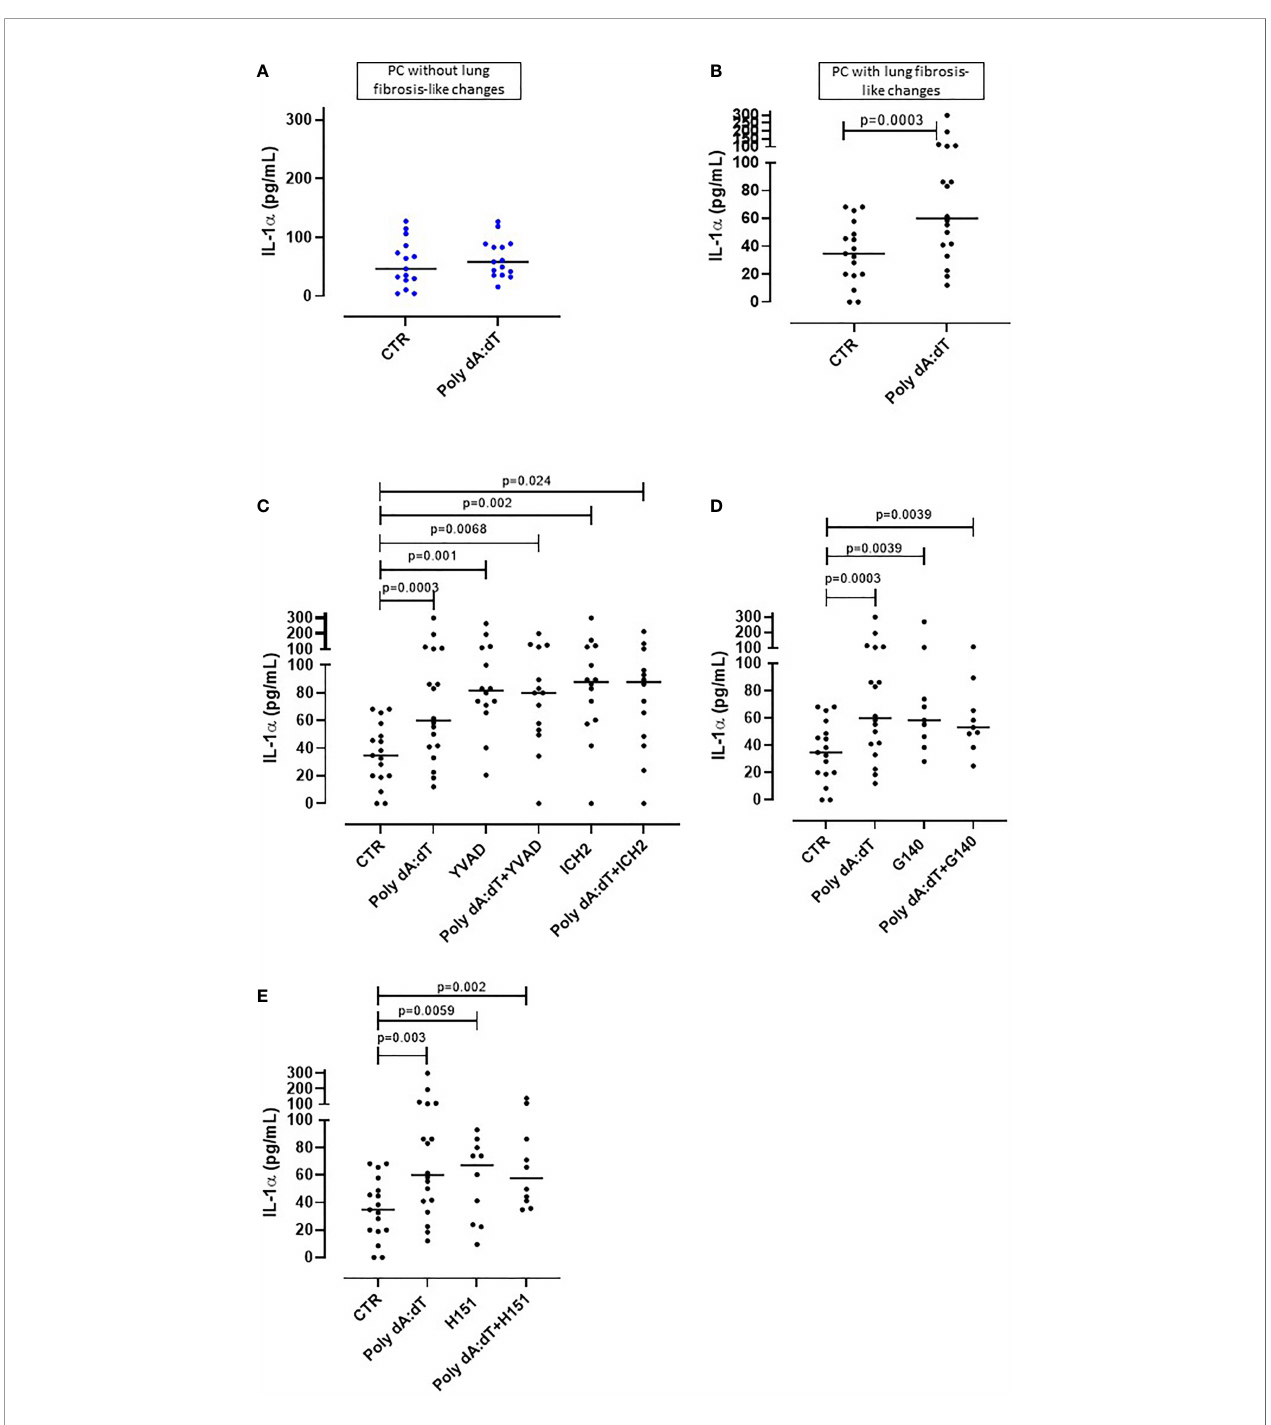
FIGURE 1 | AIM2 receptor activation induced IL-1 a release from PBMCs from Post-COVID-19 patients with fi brosis. PBMCs were stimulated with Poly dA:dT (1 m g/ mL) for 5 hours. (A) PBMCs from Post-COVID-19 (PC) patients who did not develop lung fi brosis did not release IL-1 a after AIM2 activation. (B) PBMCs from PC patients who developed lung fi brosis released greater amounts of IL-1 a after AIM2 activation. (C) Inhibition of caspase-1 and caspase-4 with Ac-YVAD-cmk (YVAD, 1 m g/mL) and ICH2 (ICH2, 6,4 m g/ml), respectively, did not reduce the release of IL-1- a after Poly dA:dT stimulation. Inhibition of (D) cGAS with G140 (2 m g/ml) or (E) STING with H-151 (H151, 1 µg/mL), did not alter the release of IL-1 a after Poly dA:dT stimulation. Data are reported as median and represented as scatter dot plots. Statistical analysis was performed using the Wilcoxon matched-pairs signed rank